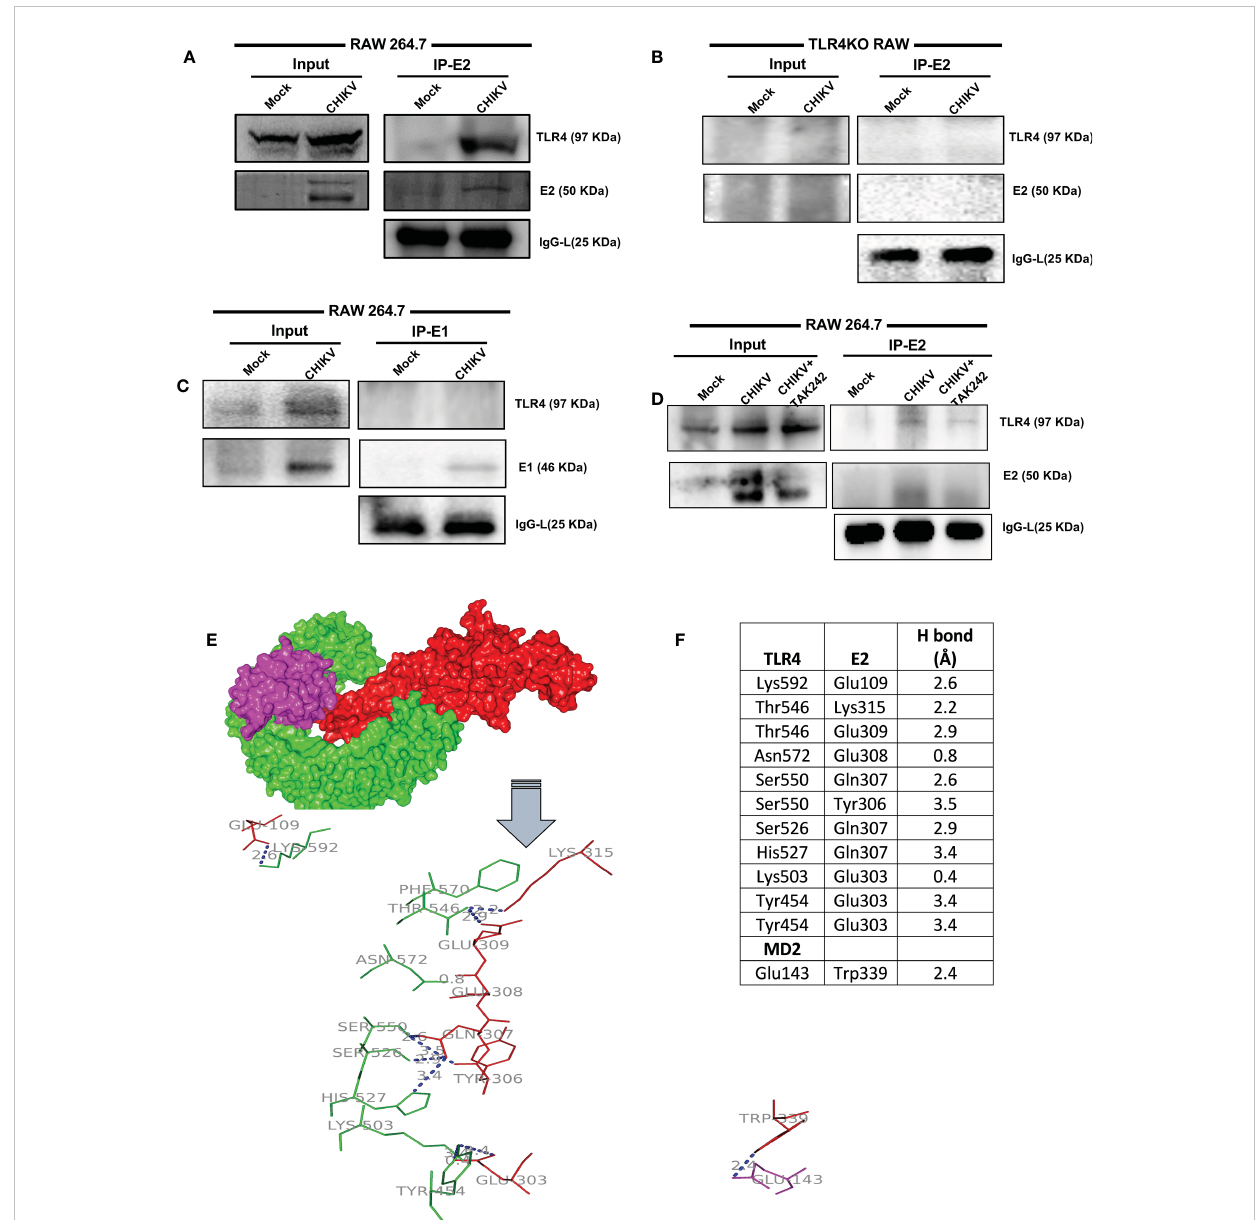
FIGURE 4 TLR4-E2 interaction facilitates CHIKV infection in host macrophages. The RAW264.7 and TLR4KO RAW cells were subjected to study functional TLR4 and E2 interaction. Both mock and CHIKV-infected cells were processed for immunoprecipitation followed by Western blot analysis. (A) For RAW264.7 cells, Western blot analysis showing the expressions of E2 and TLR4 in the whole cell lysate (left), co-immunoprecipitation analysis depicting the interaction of CHIKV E2 and TLR4 (right). (B) For TLR4KO RAW cells, Western blot analysis showing the levels of E2 and TLR4 in the whole cell lysate (left), co-immunoprecipitation analysis depicting the interaction of CHIKV E2 and TLR4 (right). (C) For RAW264.7 cells, Western blot analysis showing the expressions of E1 and TLR4 in the whole cell lysate (left), co-immunoprecipitation analysis depicting the interaction of CHIKV- E1 and TLR4 (right). (D) For RAW264.7 cells, Western blot analysis showing the expressions of E2 and TLR4 in the whole cell lysate (left), co- immunoprecipitation analysis depicting the interaction of CHIKV-E2 and TLR4 (right) in the presence/absence of TAK-242. (E) Protein – protein docking analysis reveals probable molecular interaction of MD2-TLR4 (PDB ID: 2Z64) with Chikungunya virus (CHIKV) envelope proteins E2 (PDB ID: 3N41). The protein-protein docking was done in the ZDOCK webserver using MD2-TLR4 as receptor and CHIKV-E2 as ligand (A) Interaction complex of MD2 (magenta) and TLR4 (green) with E2 (red). The polar interactions are labeled (blue) in the line diagram. (F) The residues involved in polar interactions between CHIKV-E2 and